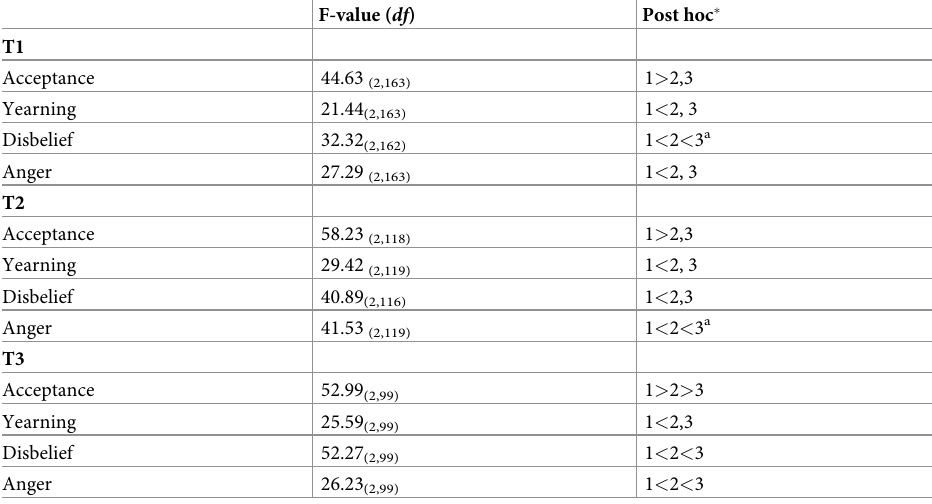
Table 4. Differences between trajectories in grief